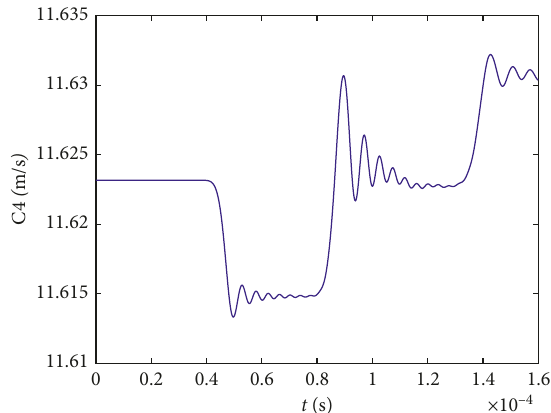
Figure 5: Velocity of the fluid acoustic wave at the point A of specimen versus